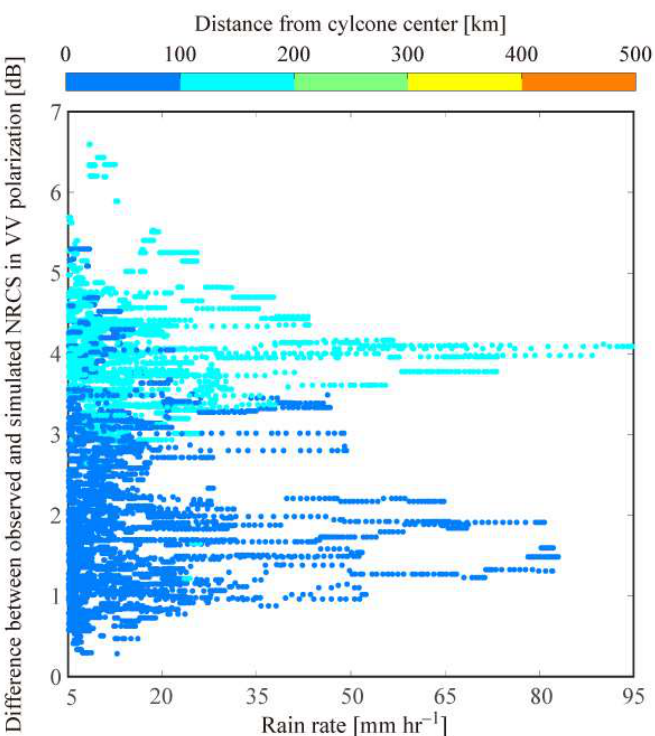
Figure 7. Relationship between the VV-polarized NRCS difference (SAR measurements versus CMOD5.N simulations) and SFMR rain rate. The color bar represents the distance between the location of SFMR measurements and the TC’s center.